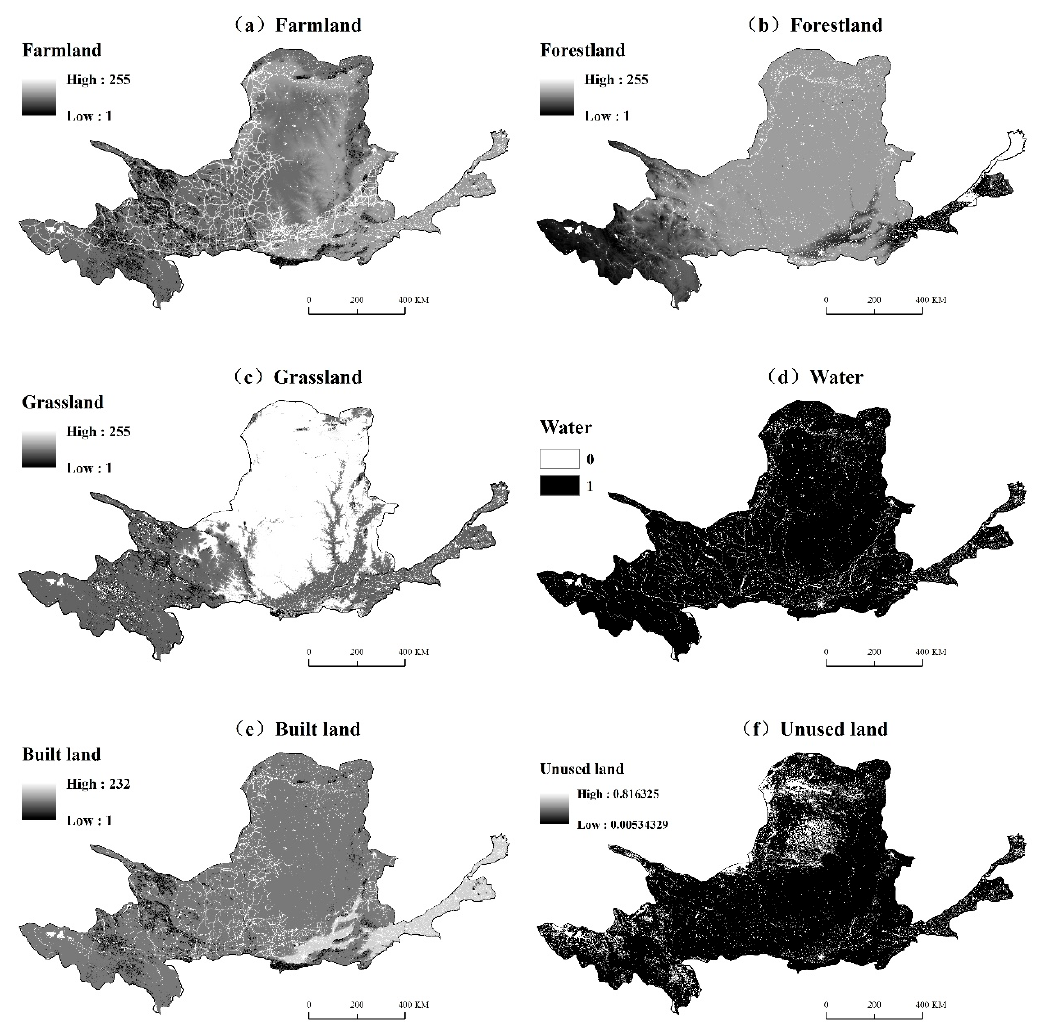
Figure 9. Comparison between simulated and actual land use maps in 2015.